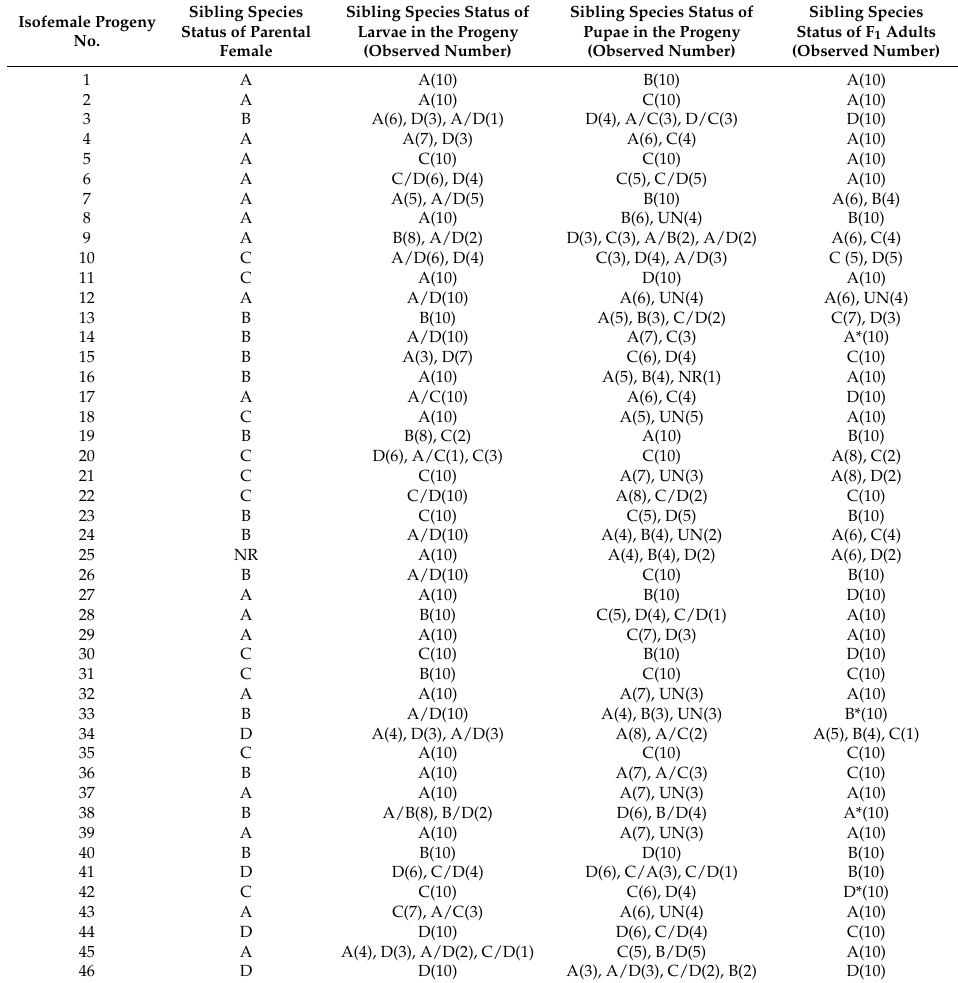
Table 5. Morphological identification of sibling species status of parental female, larvae, pupal exuviae, and F 1